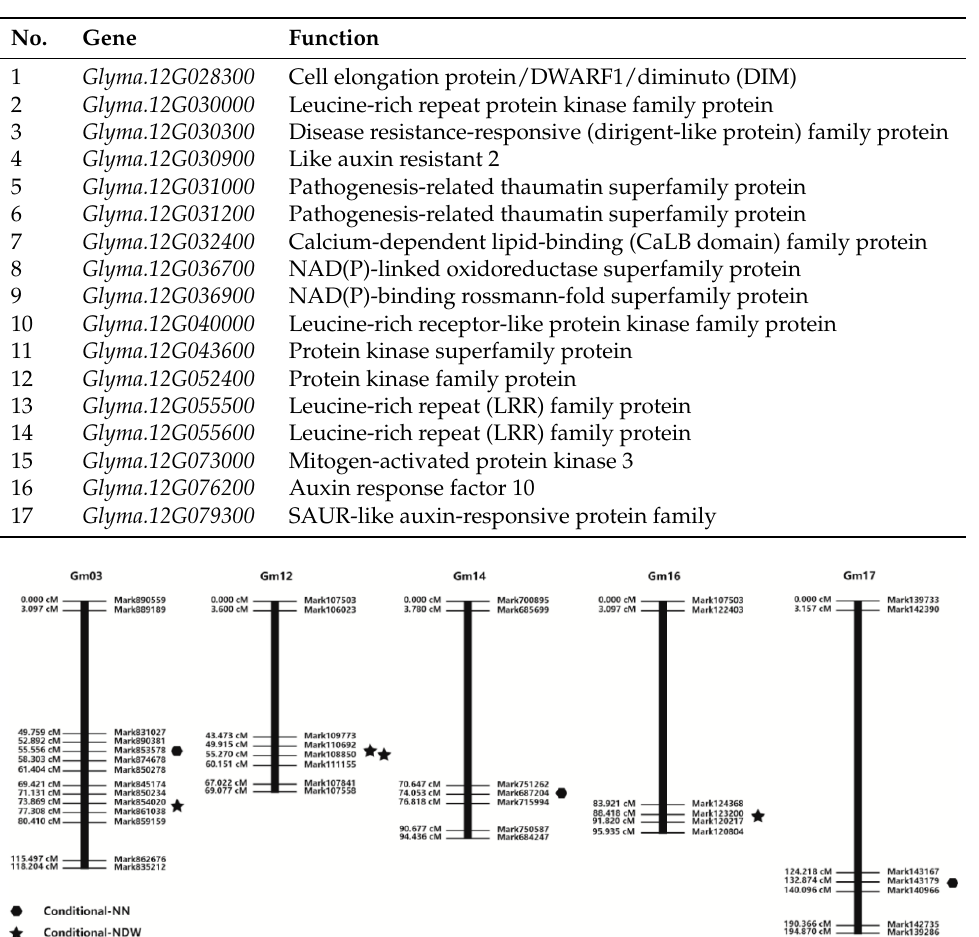
Table 3. Relevant information of candidate genes belonging to the two overlapping conditional QTLs for NDW.